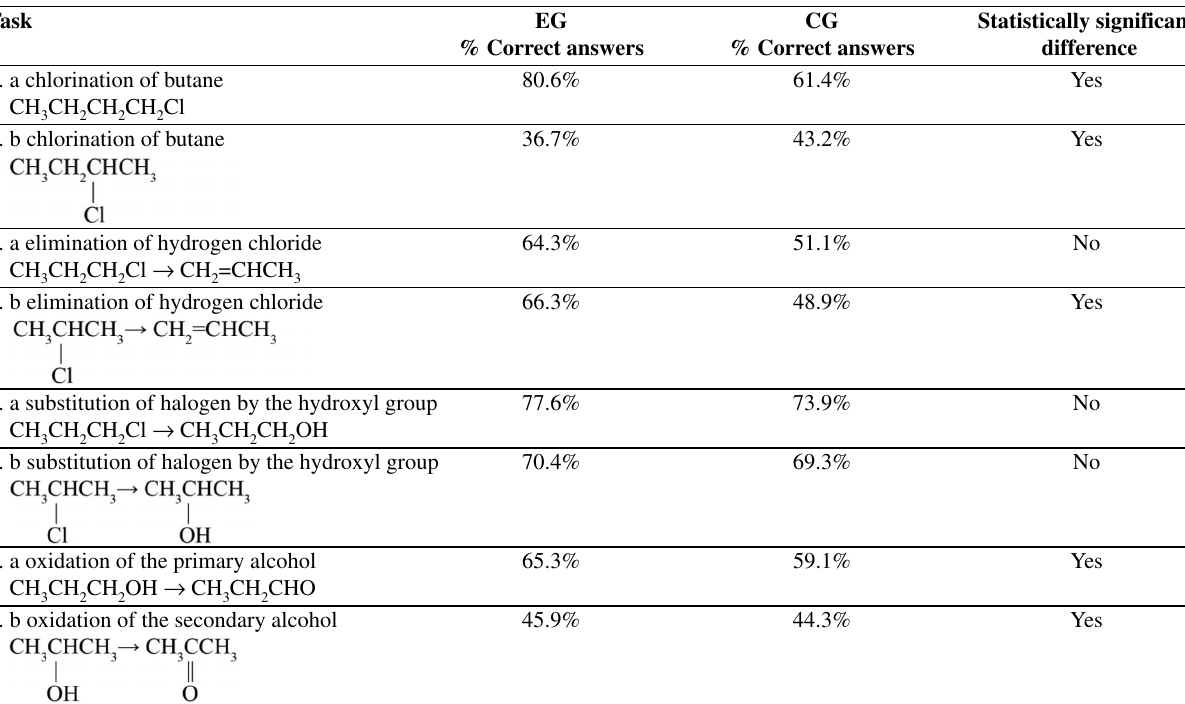
Table 9. Overview of the solving of individual tasks by the experimental and control group students.